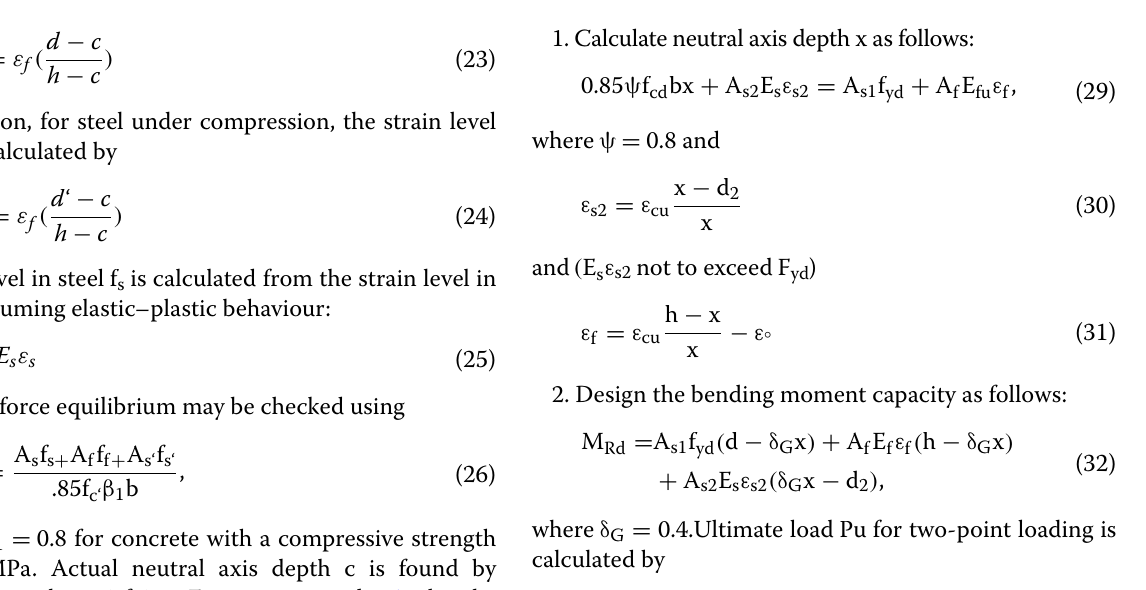
Fig. 14c shows a comparison between the experimen- tal results and the three analytical models obtained from the design codes. Equations (13–20) (ECP 208–2005)